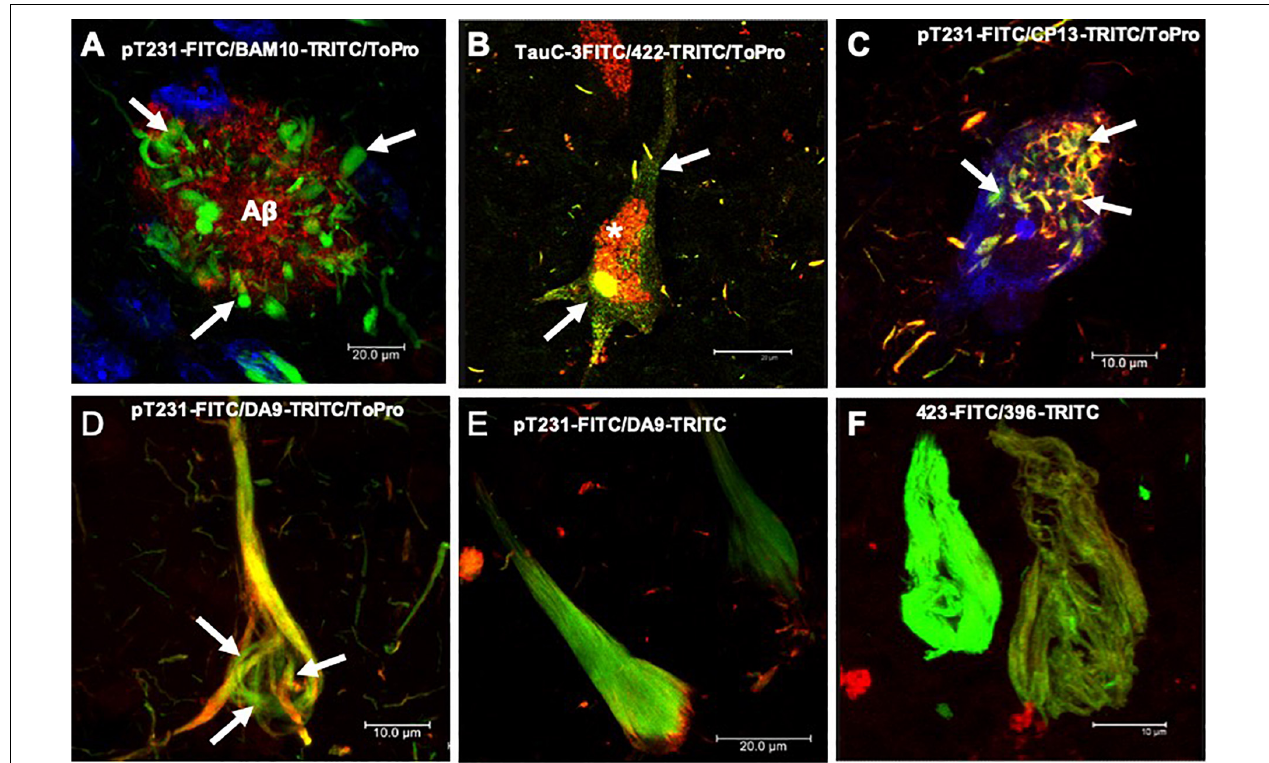
FIGURE 1 | Histopathological lesions in Alzheimer’s disease (AD) brain. (A) Amyloid plaque stained using the BAM10 antibody ( red channel ), with associated dystrophic neurites ( arrows ), and nuclei stained with To-Pro ( blue ). (B–F) Evolution of the aggregation of the tau protein recognized by different antibodies directed against phosphorylated and truncated tau proteins. (B) Pre-neurofibrillary tangle (NFT) characterized by a diffuse granular staining in the neuronal soma (TauC-3, green channel ; 423, red channel , arrows ). Perinuclear immunoreactivity is observed. Lipofuscin is autofluorescent in the red channel ( asterisk ). (C) Small tangles (bead-like structures, arrows ) visualized using two antibodies directed against the phosphorylated tau protein (pT231, green channel ; CP13, red channel ). (D,E) NFTs at different stages of aggregation. (D) NFT with a fibrillar structure in the form of a trabecula around the nucleus ( arrows ). (E) Compact NFT, where the PHFs have invaded the entire soma and displaced the nucleus from its original position, and visualised using pT231, which recognises a phospho-epitope within the mid domain (DA9). (F) Extracellular NFTs, the last stage of aggregation of the tau protein. In the neuronal soma, this structure is much looser, lacking a cell membrane and a nucleus. It consists of the minimum core of the filament (PHF core) and reacts with antibody 423, which recognizes truncation at Glu-391 ( green channel ) and phospho-tau S396 ( red channel ). Images obtained with a Leica SP8 confocal microscope.